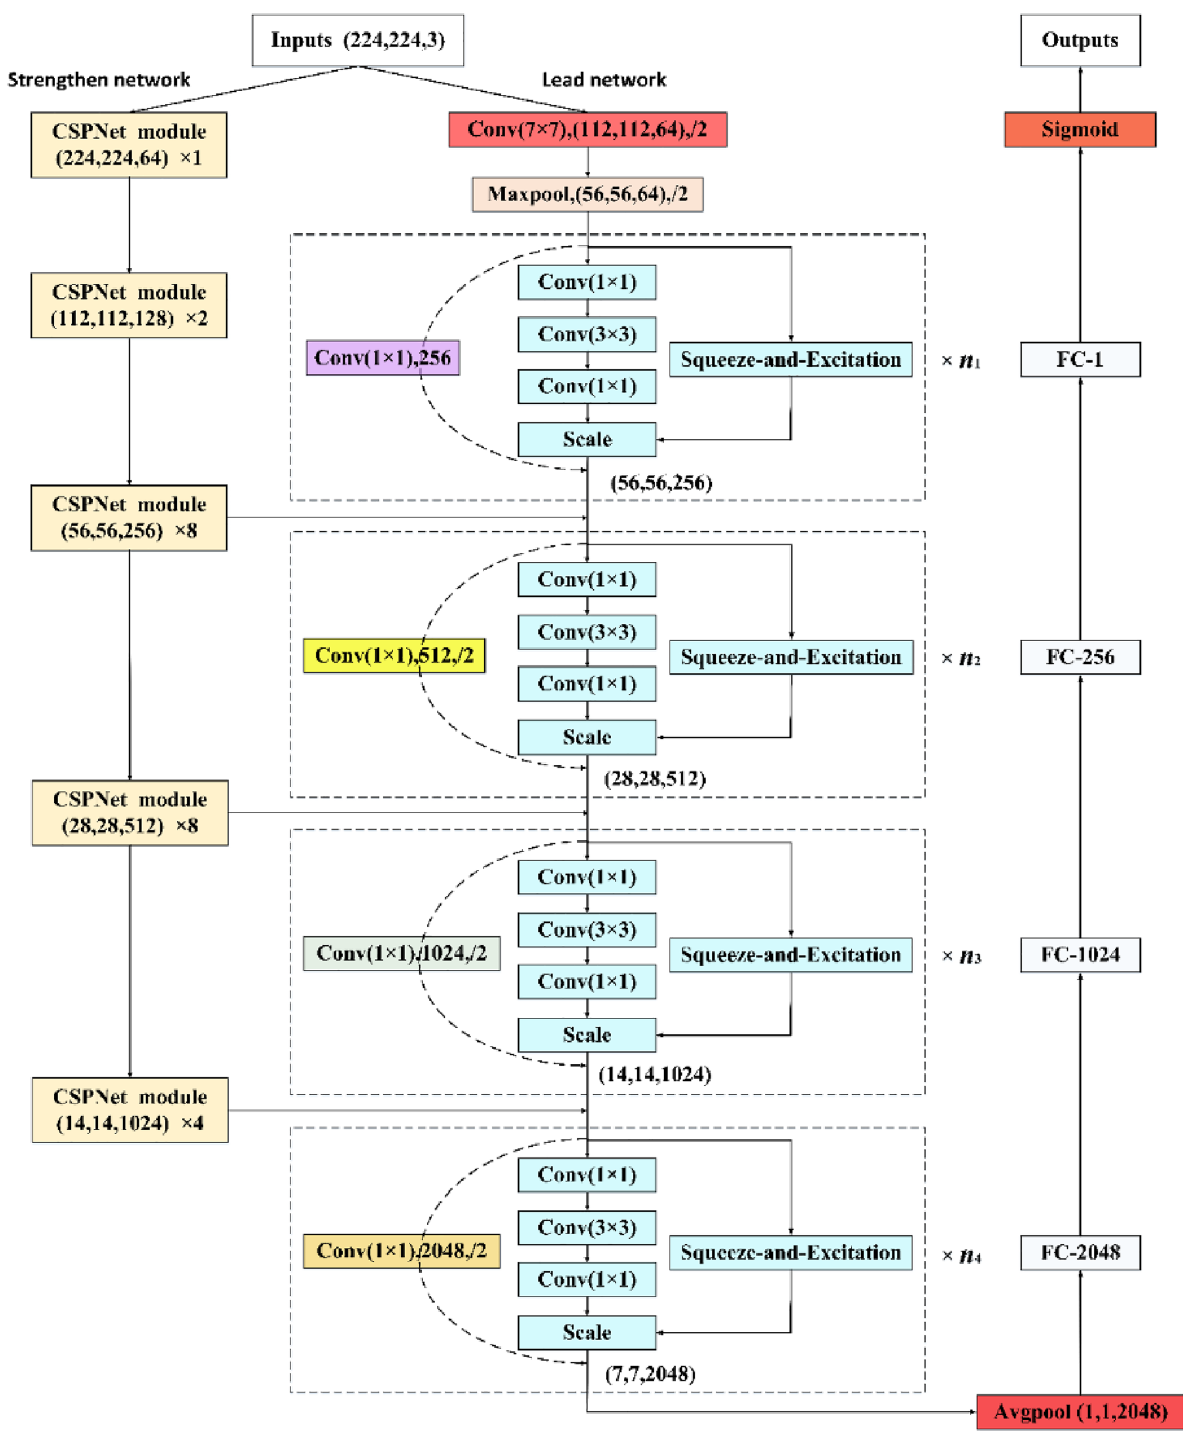
Figure 3. The structure of SSEResNet regression